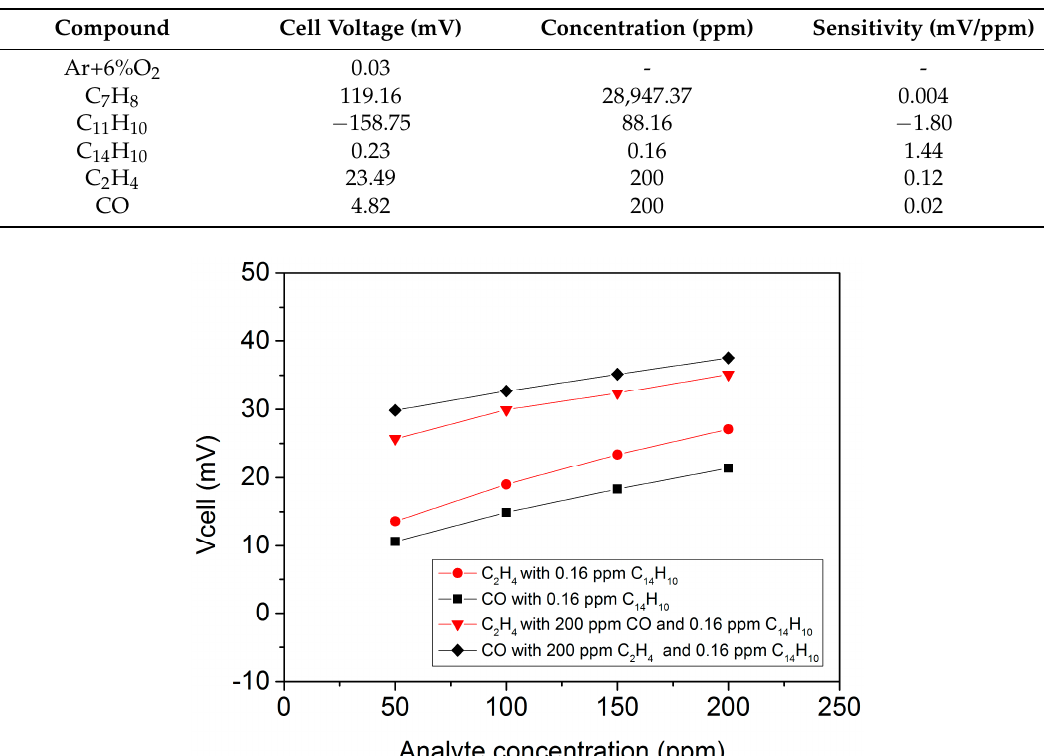
Table 3. Sensor response to several conditions: Ar+6%O 2 base gas, toluene, methylnaphtalene, phenantrene, C 2 H 4 , and carbon monoxide. Concentration, cell voltage, and sensor sensitivity as mV/ppm are provided.